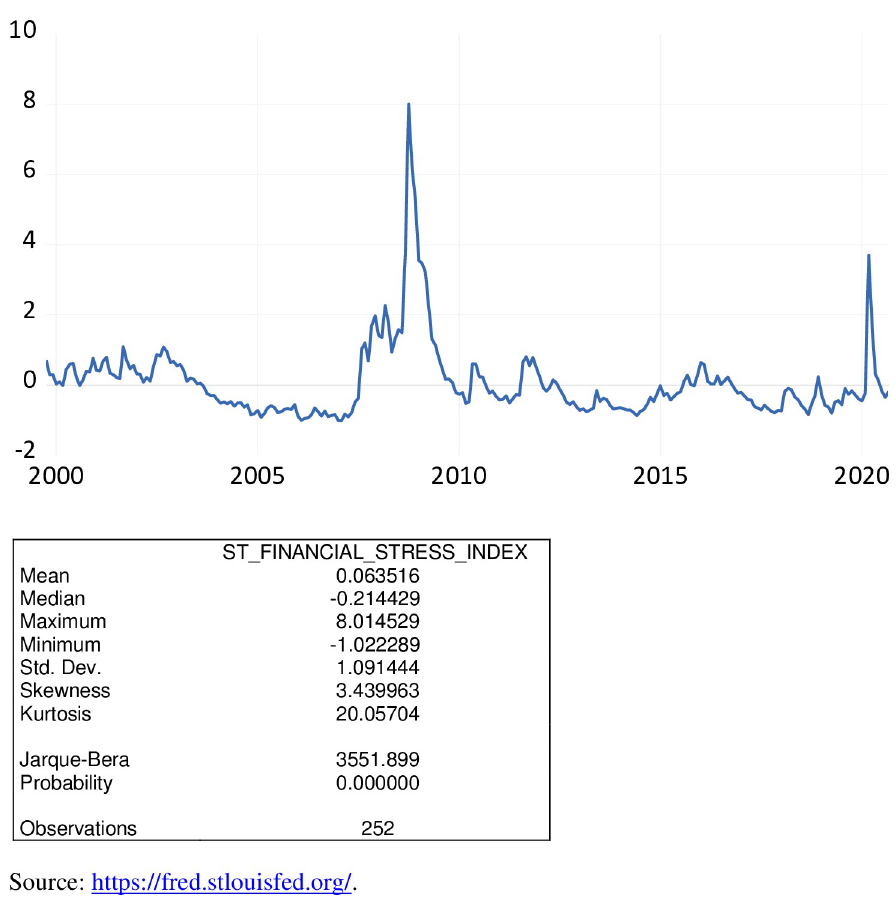
Fig 8. The St. Louis finanical stress index, October 1999 to September